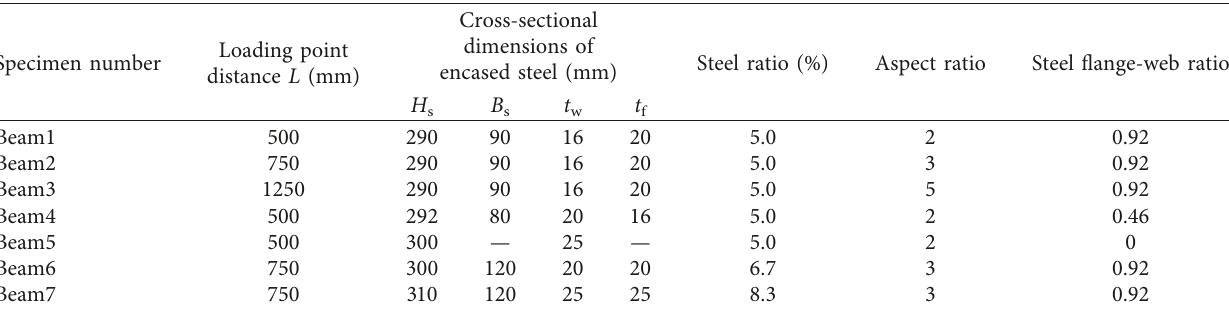
Figure 1: (a) Dimensions of the specimens and the steel reinforcement details (unit: mm). (b) Encased steel details (unit: mm). (c) Perspective view of the specimens. Table 1: Detailed parameters of